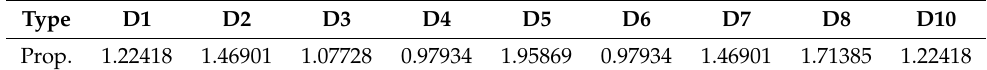
Table 14. P2P total delays: Data concentrators to the SCADA (in ms).